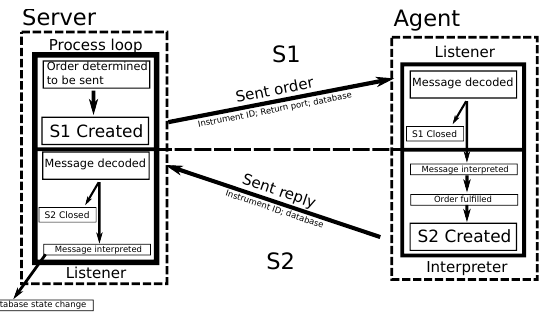
Figure 1. Illustration of the communication between a server and agent applications. The full commu- nication requires the creation of 2 sockets (S1 & S2) between a total of 4 independent processes evenly divided between the server and agent